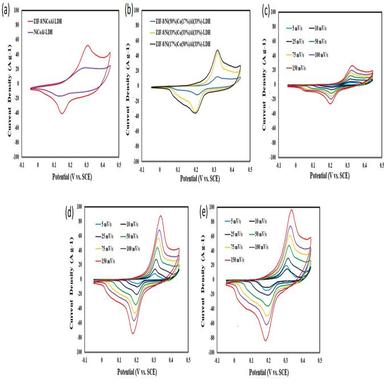
CV curves for (a) NiCoAl-LDH and ZIF-8/NiCoAl-LDH at 50 mV s − 1 and for (b) ZIF-8/LDHs at 50 mV s − 1 , (c) ZIF-8/Ni(50%)Co(17%)Al(33%)-LDH, (d) ZIF-8/ Ni(33%)Co(33%)Al(33%)-LDH, (e) ZIF-8/Ni(17%)Co(50%)Al(33%)-LDH at different scan rates.